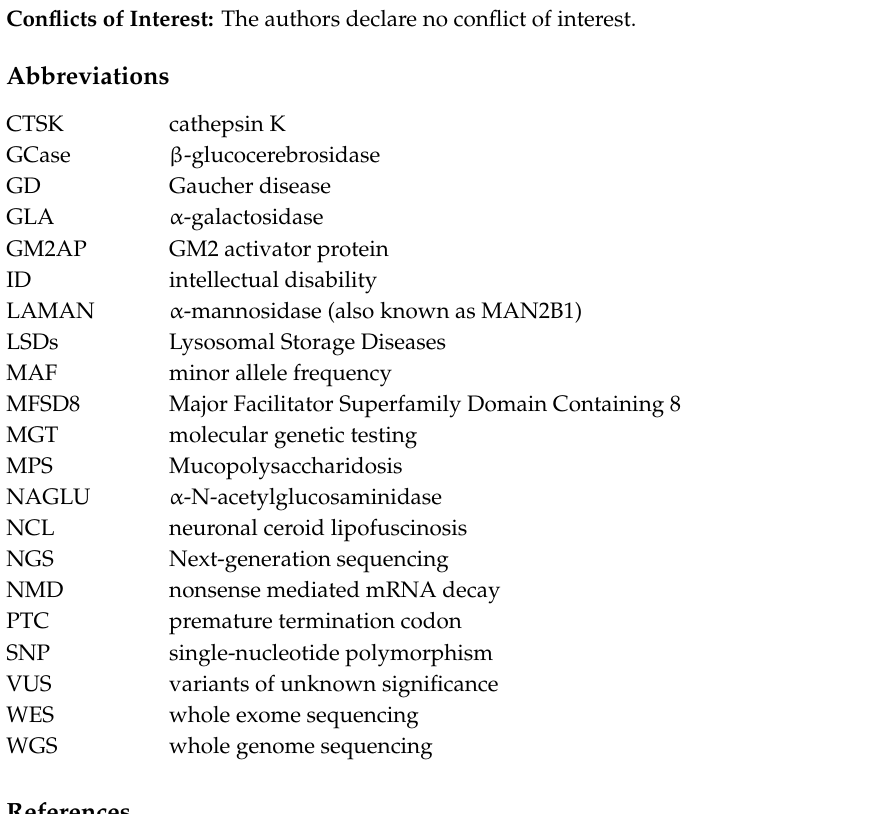
Figure S1. Three-dimensional structure representation of NAGLU using PyMol. Stereo figure